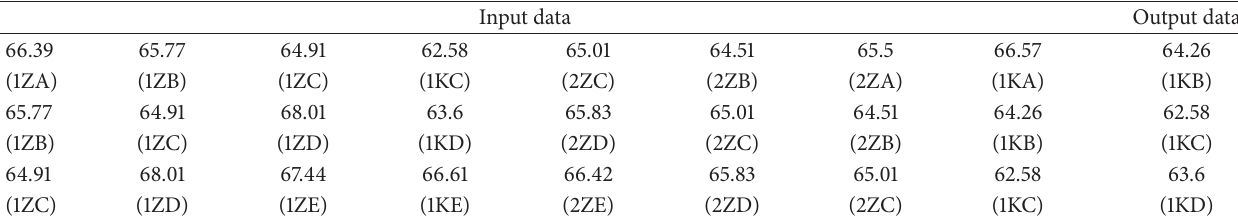
Table 3: An example of input and output variables in SVM model dB.